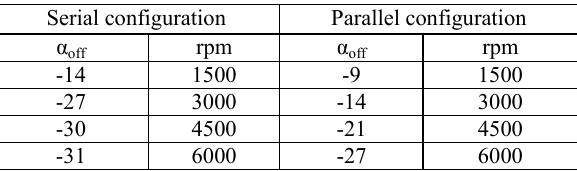
Fig. 2. Maximum output torque and drive efficiency vs. rotational speed in series and parallel configurations . Table 1. Applied values of the switch-off angle α off for serial and parallel configuration at different speeds.